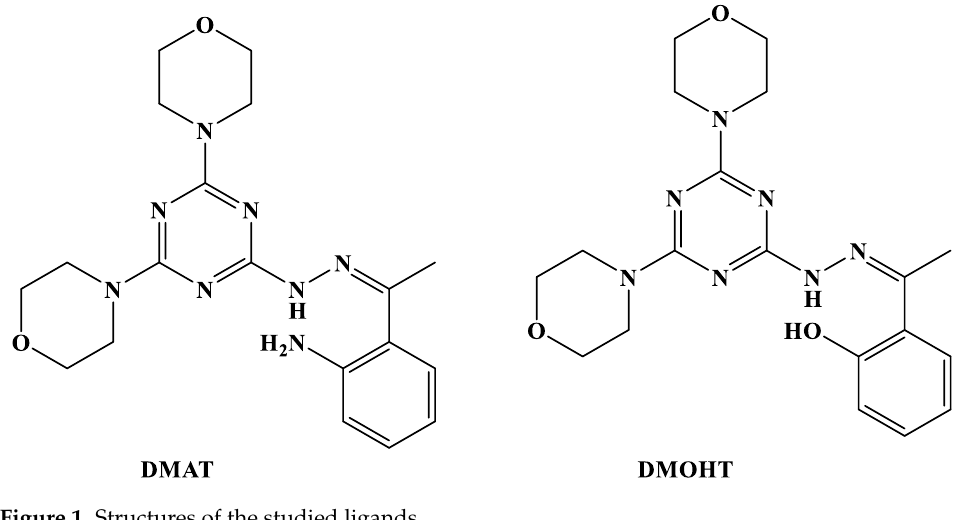
Figure 1. Structures of the studied